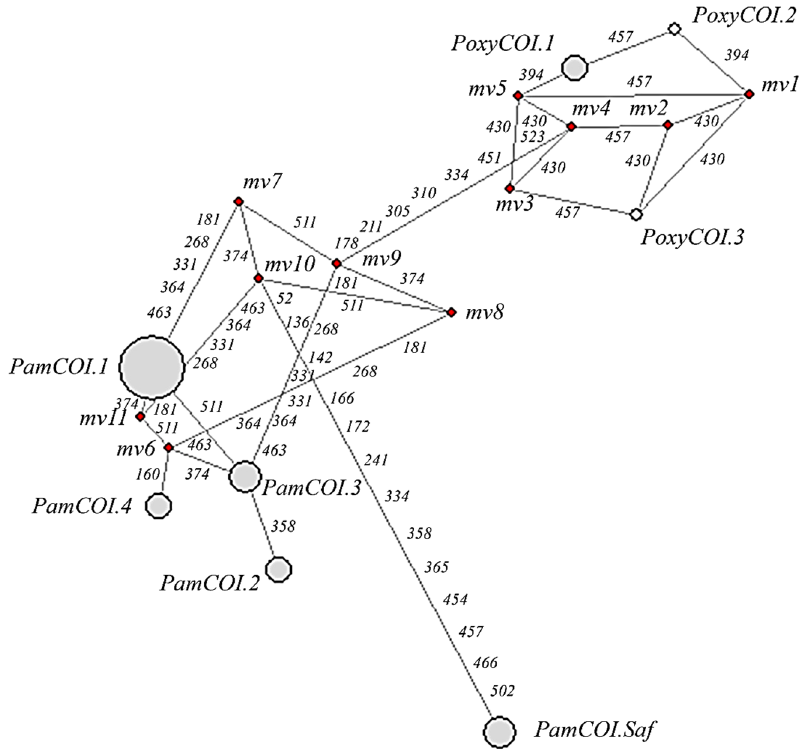
Figure 2. Median-joining network showing the mutational distance among mitochondrial DNA COI haplotypes from P. americanus ( PamCOI ) and P. oxygeneios ( PoxyCOI ) (see Table 2 above for sequence data). Median vectors (mv, in red dots) indicate likely extant but non-sampled sequences. The diameter of circles indicates the relative frequency of each haplotype.